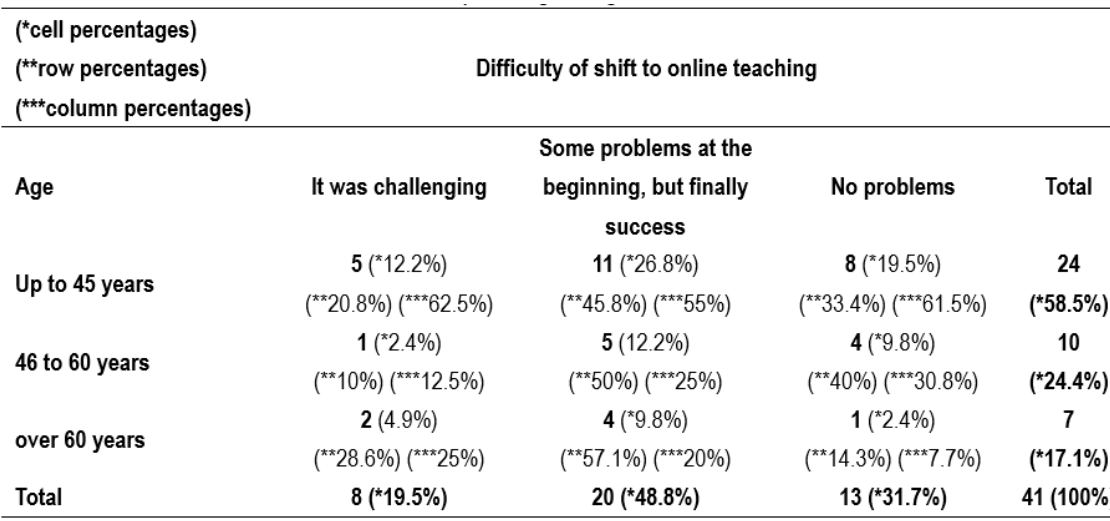
The success of shift to online education depending on